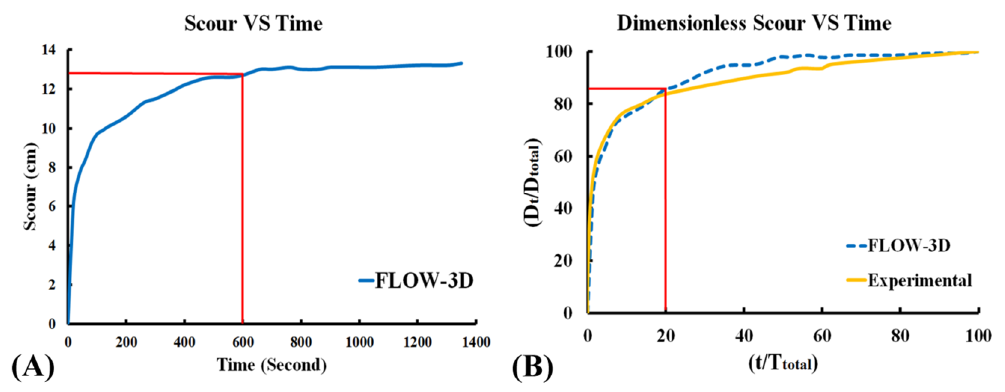
Figure 4. Scouring-time chart.